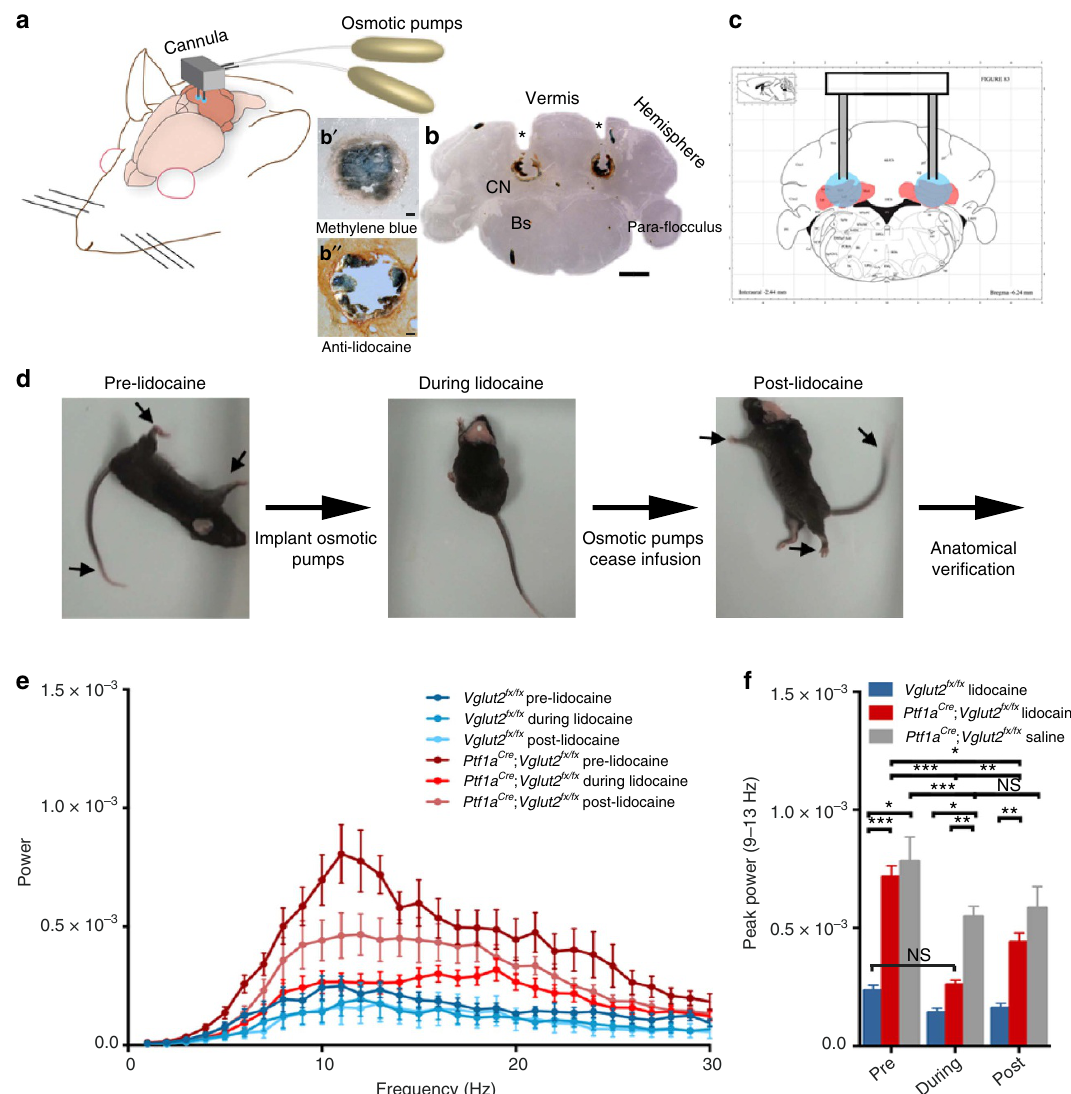
Figure 7 | Lidocaine delivery to the interposed cerebellar nuclei eliminates tremor and improves movement in Ptf1a Cre ;Vglut2 fx/fx mutant mice. ( a ) A schematic example of delivery of lidocaine via osmotic pumps to a mouse cerebellum. Schematic adapted with permission, from drawings published in ref. 28. ( b ) Anatomical verification of surgical targeting of the cannula to the cerebellar nuclei. In the higher power view of where the cannula tip was located ( b 0 ), the methylene blue staining approximates the local impact of the lidocaine injection and ( b ’’) the lidocaine immunodetection was used to examine the local spread of lidocaine within the cerebellar nuclei. Scale bar in ( b ), 1mm. Scale bar in ( b ’ and b ’’), 100 m m. ( c ) Atlas schematic 75 demonstrating the location of the cerebellar nuclei (highlighted in red) and the bilateral infusion of lidocaine into the interposed nuclei (highlighted in blue). Schematic reproduced in part, with permission, from Paxinos and Franklin 75 . ( d ) Stills of videos of a dystonic mouse before, during and after lidocaine infusion. Arrows point to stiff extended limbs and tail. ( e ) Tremor power/frequency graph of Vglut2 fx/fx and Ptf1a Cre ;Vglut2 fx/fx mice before, during and after lidocaine infusion. Error bars are defined as s.e.m. ( f ) Quantification of peak power of Vglut2 fx/fx (pre versus during: Student’s paired t -test P value ¼ 0.1117), Ptf1a Cre ;Vglut2 fx/fx (pre versus during: Student’s paired t -test P value ¼ 0.0001) and Ptf1a Cre ;Vglut2 fx/fx sham (pre versus during: Student’s paired t -test P value ¼ 0.0068; during versus post: Student’s paired t -test P value ¼ 0.2941). Vglut2 fx/fx during versus Ptf1a Cre ;Vglut2 fx/fx during Student’s unpaired t -test P value ¼ 0.131; n ¼ 7 Vglut2 fx/fx mice with lidocaine, 14 Ptf1a Cre ;Vglut2 fx/fx mice with lidocaine, 4 Ptf1a Cre ;Vglut2 fx/fx mice with saline. Error bars are defined as s.e.m. Either paired or unpaired Student’s t -tests were used as noted. * P o 0.05, ** P o 0.01 and *** P o